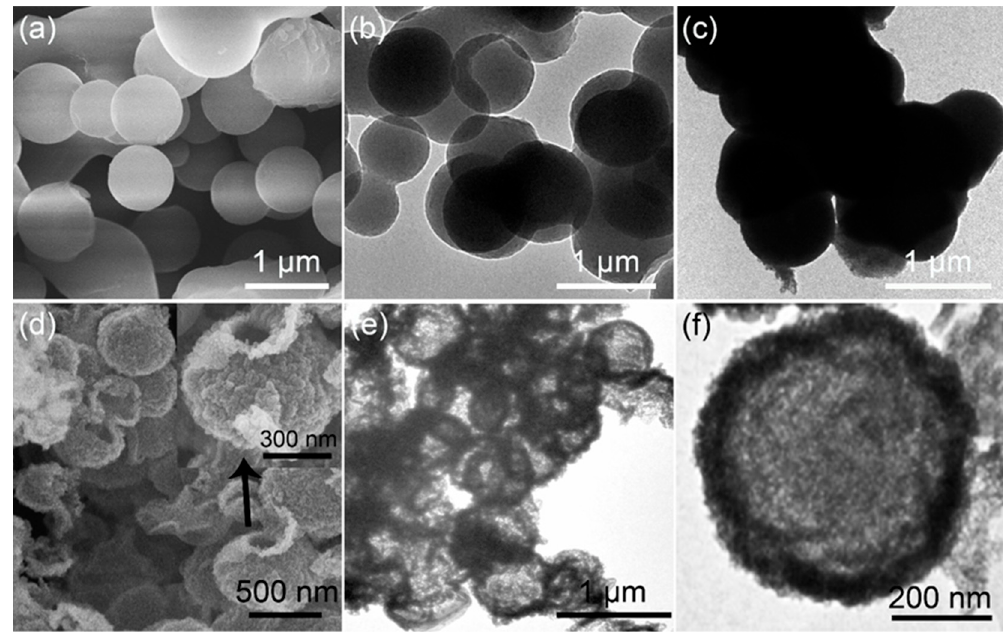
Figure 1. ( a ) SEM and ( b ) TEM of carbonaceous spheres templates; ( c ) TEM of carbonaceous spheres adsorbed Zn 2+ precursors; ( d ) SEM of ZnO hollow microspheres (HMS); ( e ) low and ( f ) high magnification TEM of ZnO HMS.